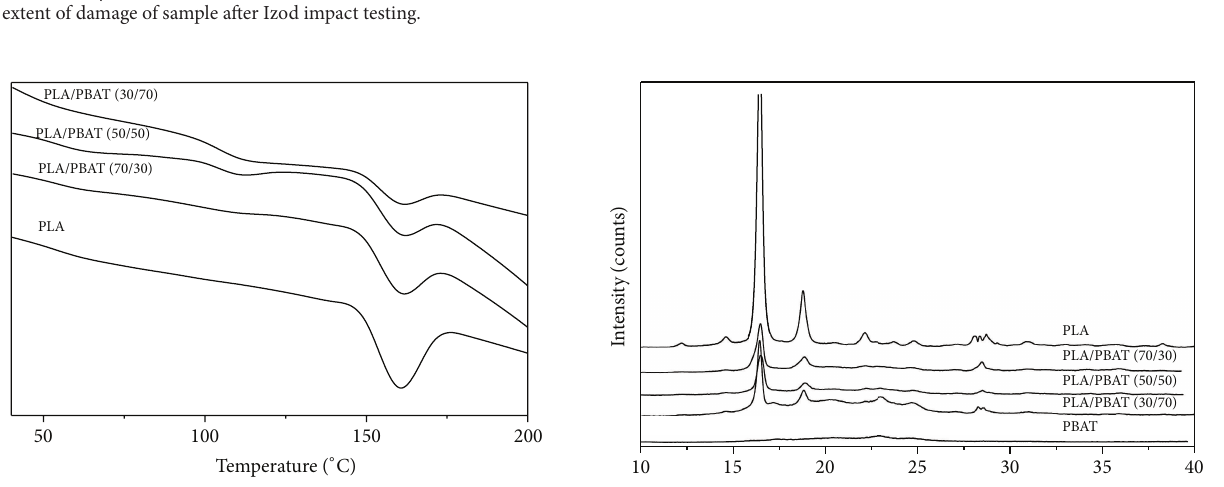
Figure 3: PLA/PBAT blends DSC annealing at 100 ∘ C for 8hr.